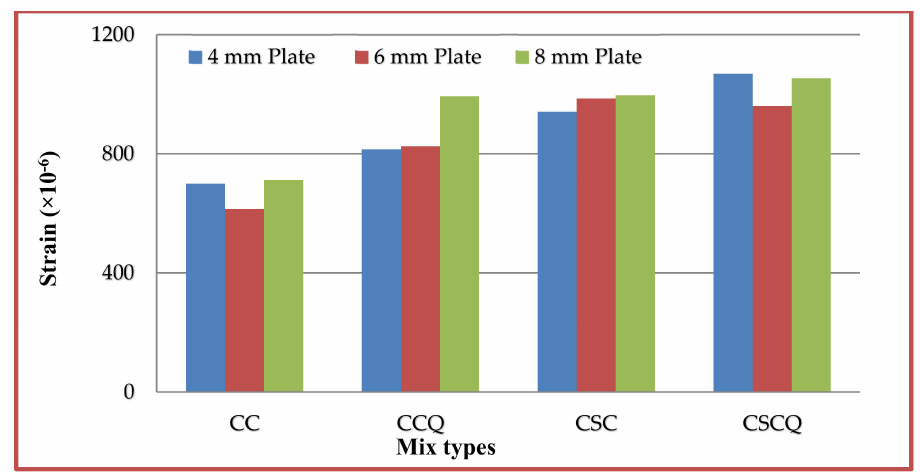
Figure 24. Top compression plates strains of di ff erent